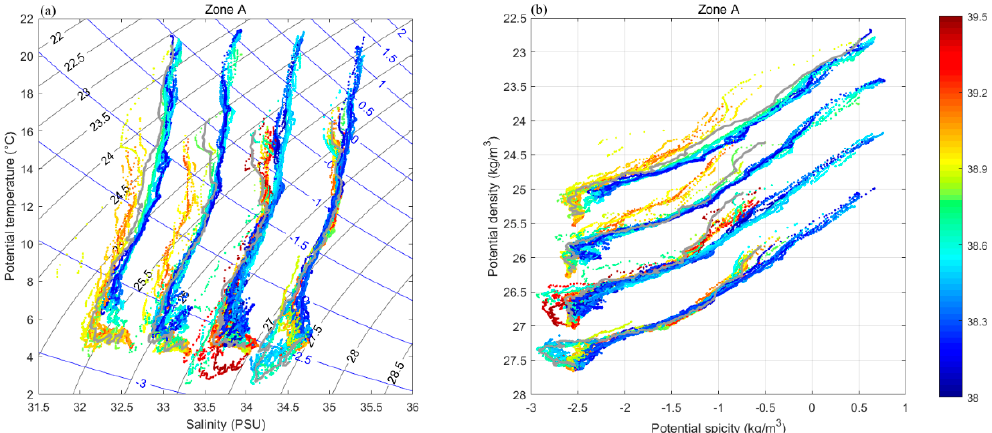
Figure 4. ( a ) Potential temperature–salinity ( θ -S) diagram of the four sections. The A1/A2/A3/A4 sections’ results are shifted along the x axis: Δ x = − 1.5/ − 0.75/0/0.75. The gray curves indicate the representative profiles of the A1–A4 sections obtained at 38.84° N, 38.83° N, 38.76° N and 38.60° N, respectively, to show the thermohaline intrusions. Potential density (black contours in kg/m 3 ) and potential spicity (blue contours in kg/m 3 ) in θ -S space are also shown. ( b ) Potential density-potential spicity ( σ - π ) diagram of the four sections. The A1/A2/A3/A4 sections’ results are shifted along the y axis: Δσ = − 1.5/ − 0.75/0/0.75. The gray curves are the same representative pro fi les as that of ( a ).